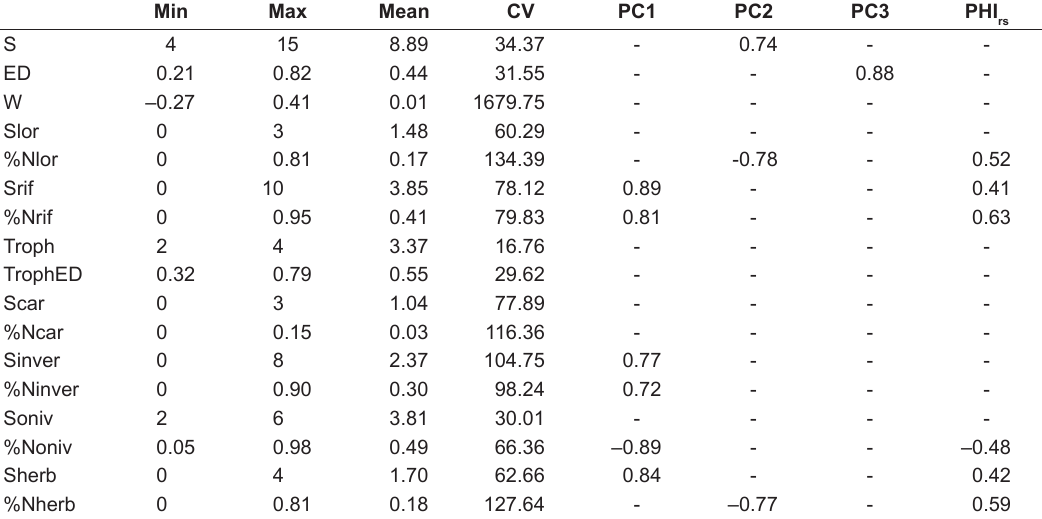
Table 5. Minimum (Min), Maximum (Max), Mean and coefficient of variation (CV) of the candidate metrics (see Table 3 legend) for the IBI. Range and responsiveness significance: PCA metric loadings (PC1, PC2, PC3) and Spearman’s rank correlation coefficient with PHI (PHI rs